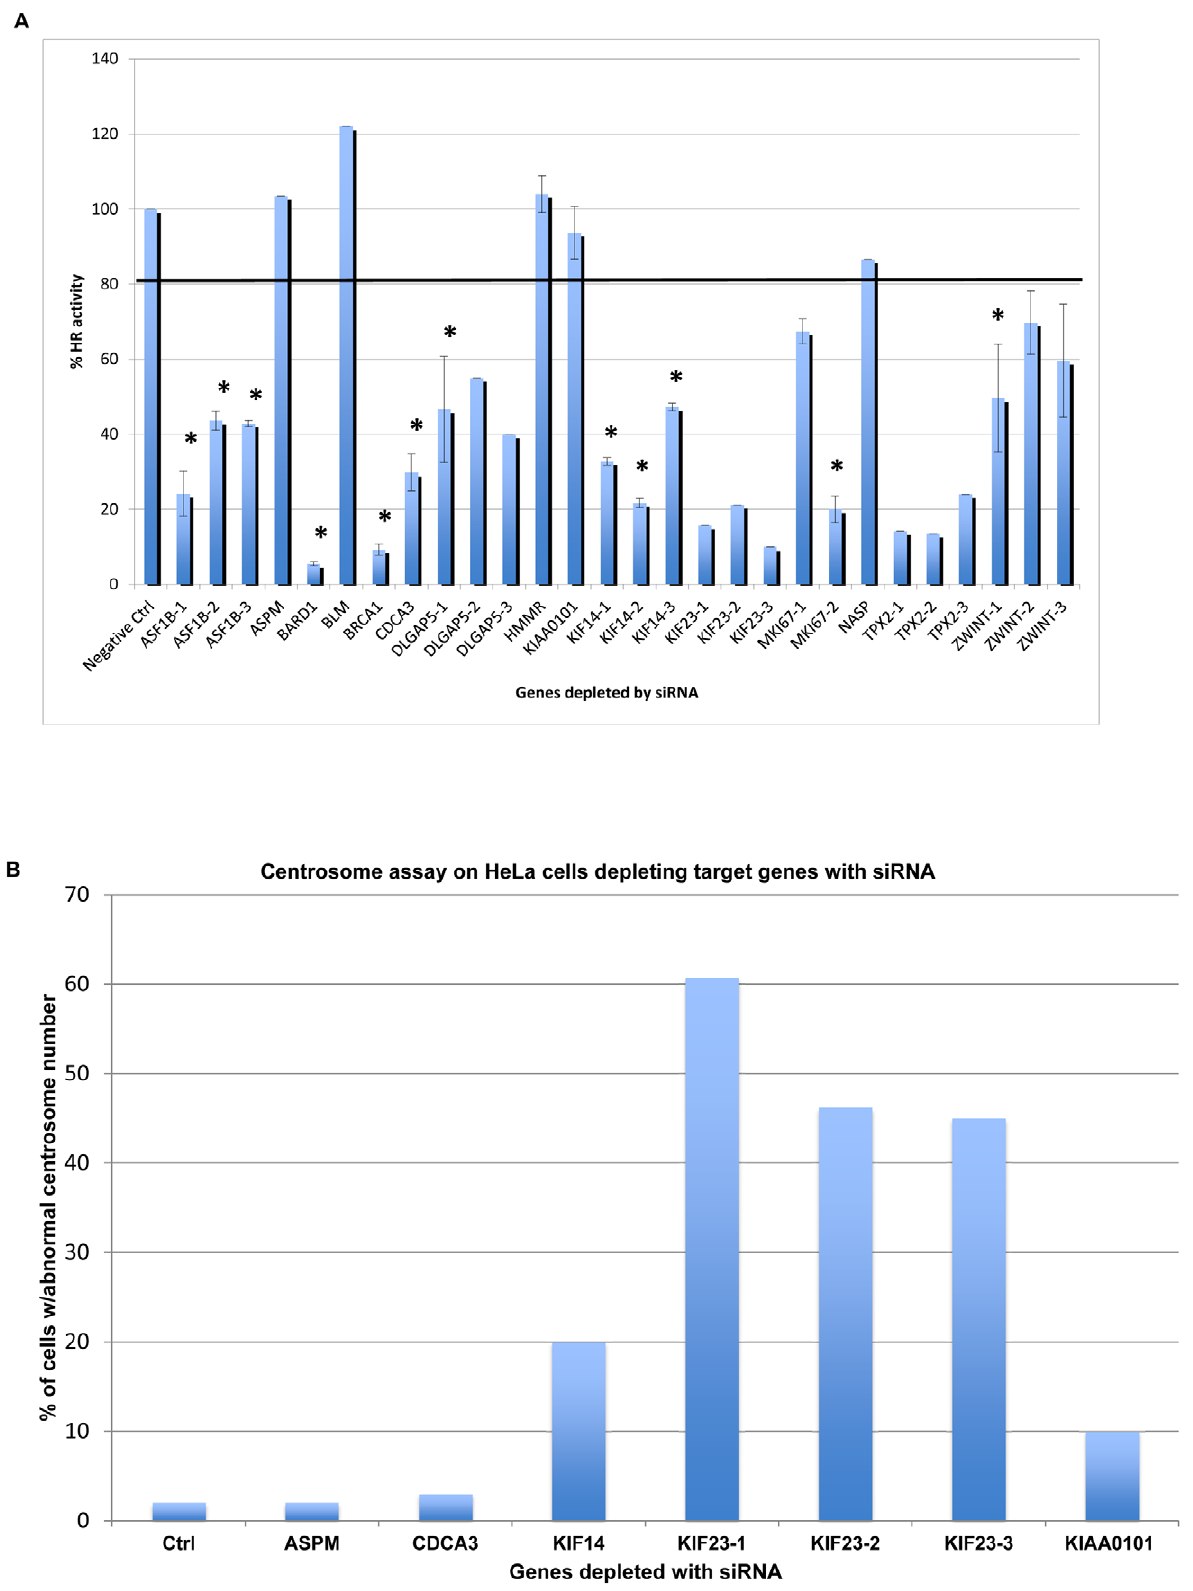
Figure 5. Cell-based assays to test gene involvement in the genome stability maintenance using RNAi. Cells transfected with firefly gene GL2 siRNA were used as the negative control for both assays. A: HR assay on HeLa cells depleting target gene expression by siRNA. Error bar represents standard error. Asterisks indicate the results with statistically significant decreased activity upon siRNA depletion using Student’s test